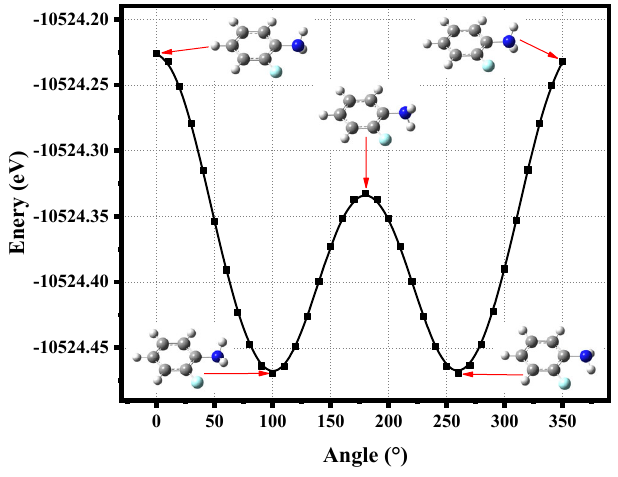
Figure 1. o -Fluoroaniline energy varies with angle, and the five structures of the molecule are given. Calculation method and basis set: DFT and CAM-B3LYP/6-311+G(d,p).